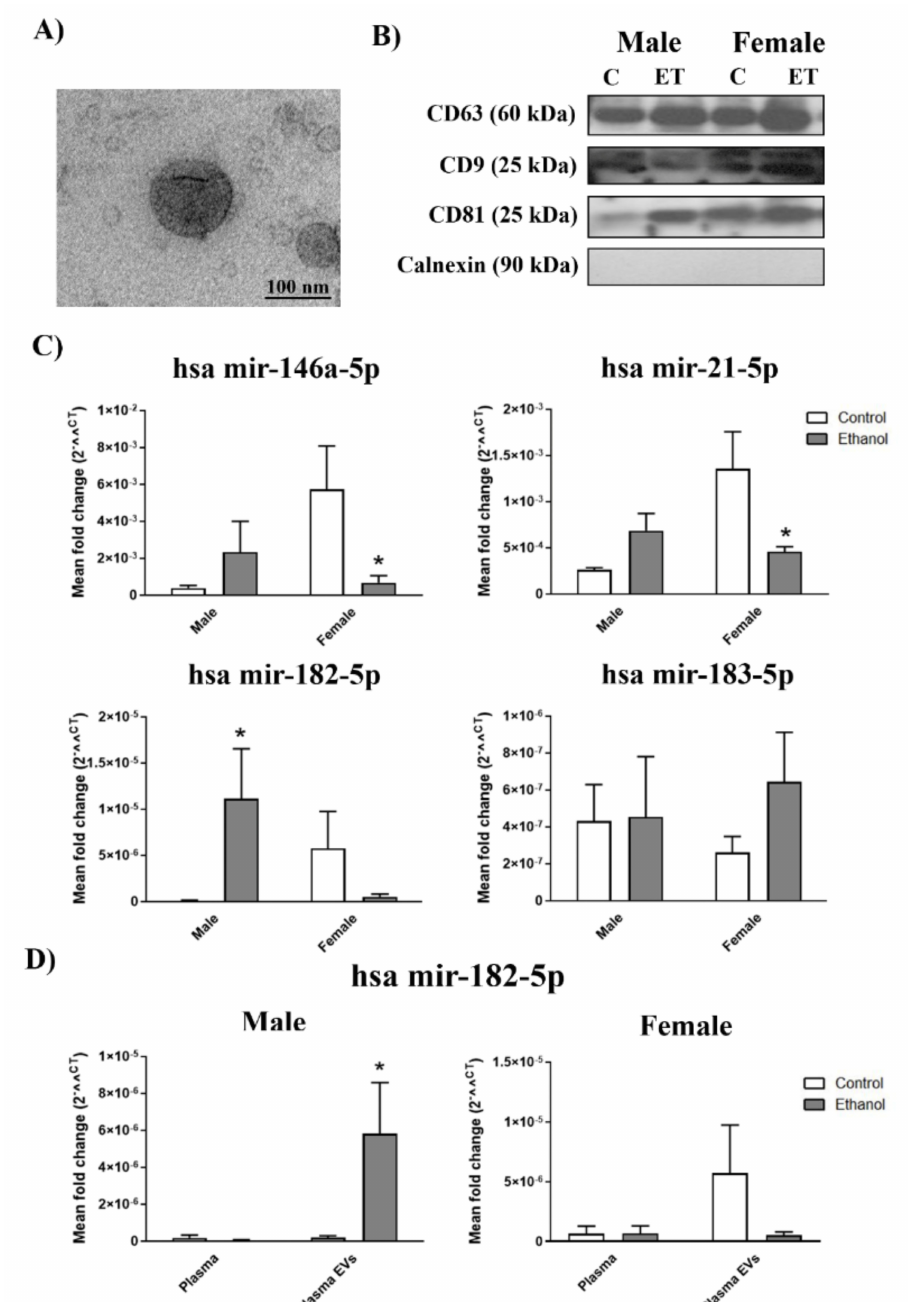
Figure 1. Inflammatory-related miRNA profile in the human plasma extracellular vesicles (EVs) deriving from the ethanol-intoxicated adolescents. ( A ) Human plasma EVs characterization by electron microscopy. Scale bar, 100 nm. ( B ) Representative immunoblots of the expressions of CD9, CD63, CD81, and calnexin of the human plasma EVs. ( C ) Graphs represent the expressions of the plasma EV miRNAs (mir-146a-5p, mir-21-5p, mir-182-5p, and mir-183-5p) of the human adolescent females and males after acute ethanol intoxication and the data of the corresponding healthy control individuals. ( D ) Graphs represent the mir-182-5p expression in the plasma and plasma EVs of the human adolescent females and males after acute ethanol intoxication and the data of the corresponding healthy control individuals. Data represent mean ± SEM, n = 6 independent experiments. * p < 0.05 compared to their respective healthy control individuals, according to the two-way ANOVA followed by the Bonferroni post hoc